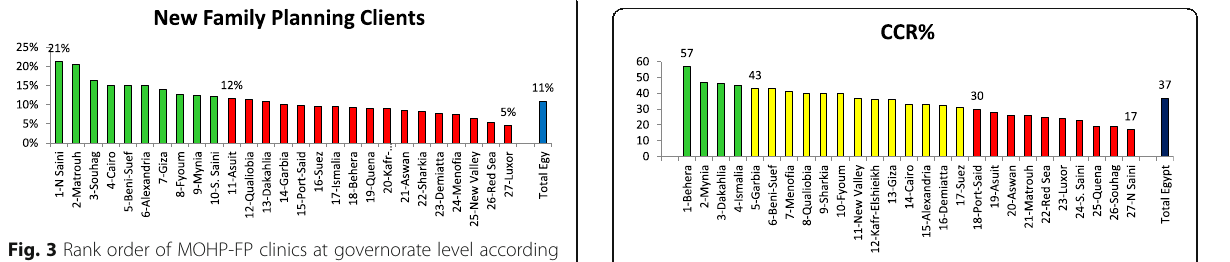
Fig. 5 Rank order of MOHP-FP clinics at governorate level according to the percent of coverage of MWRA by FP methods in